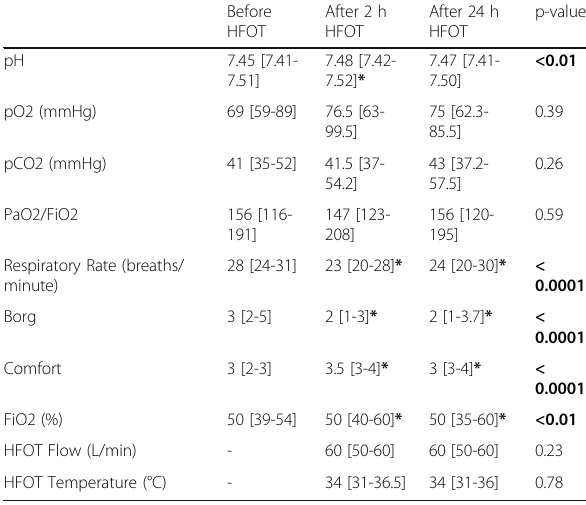
Table 1 (abstract 001753). See text for